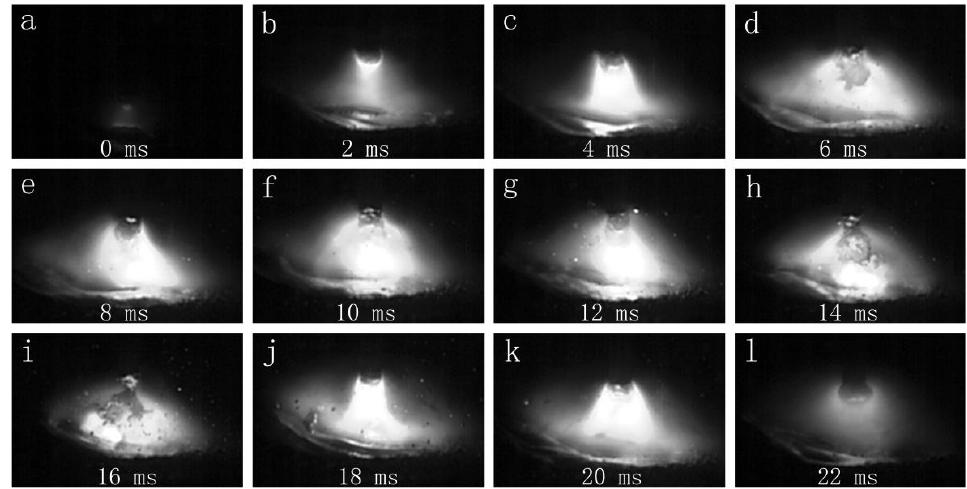
Figure 4. The droplet transfer process of the CMT mode (7150 filler wire): ( a – l ) show the droplet transfer process in chronological order.